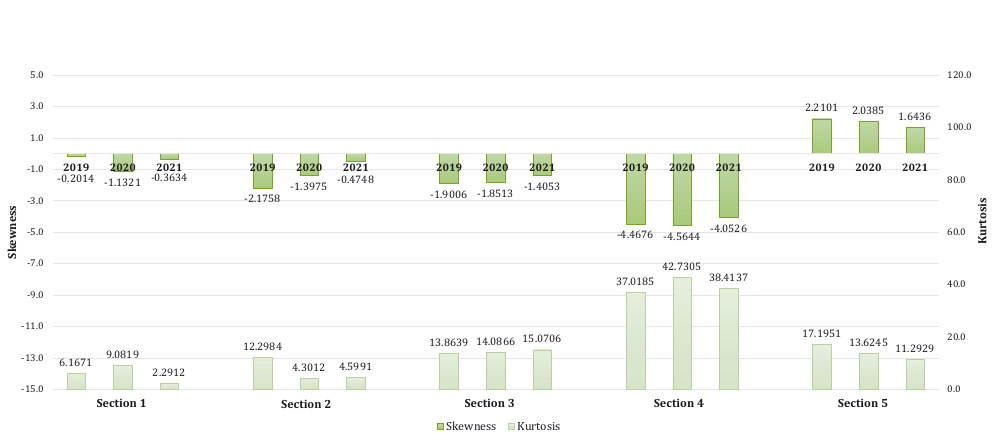
Figure 24. Statistical characteristics of the longitudinal level values of the selected sections